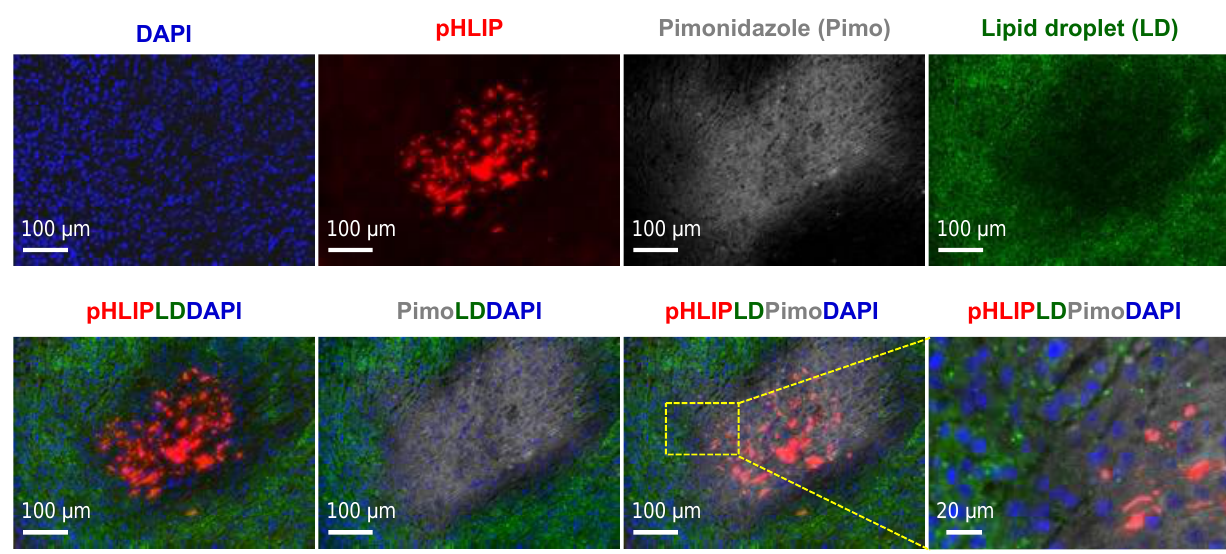
Figure 6. Spatial relationships among the intratumoral distribution (ITD) of pHLIP, hypoxia, and lipid droplets. pHLIP distribution (AF546-pHLIP, red), pimonidazole-stained hypoxia (gray), and lipid droplet staining (green) were examined at the same sites of the same tumor sections. Shown here are images acquired from a representative high pHLIP-accumulated region in a U87MG tumor section. The lipid droplet-specific fluorescent probe Lipi-Green was used for staining the lipid droplets. Blue indicates nuclei stained with DAPI. An enlarged view of the dotted rectangle clearly shows the cellular localization of the lipid droplets.